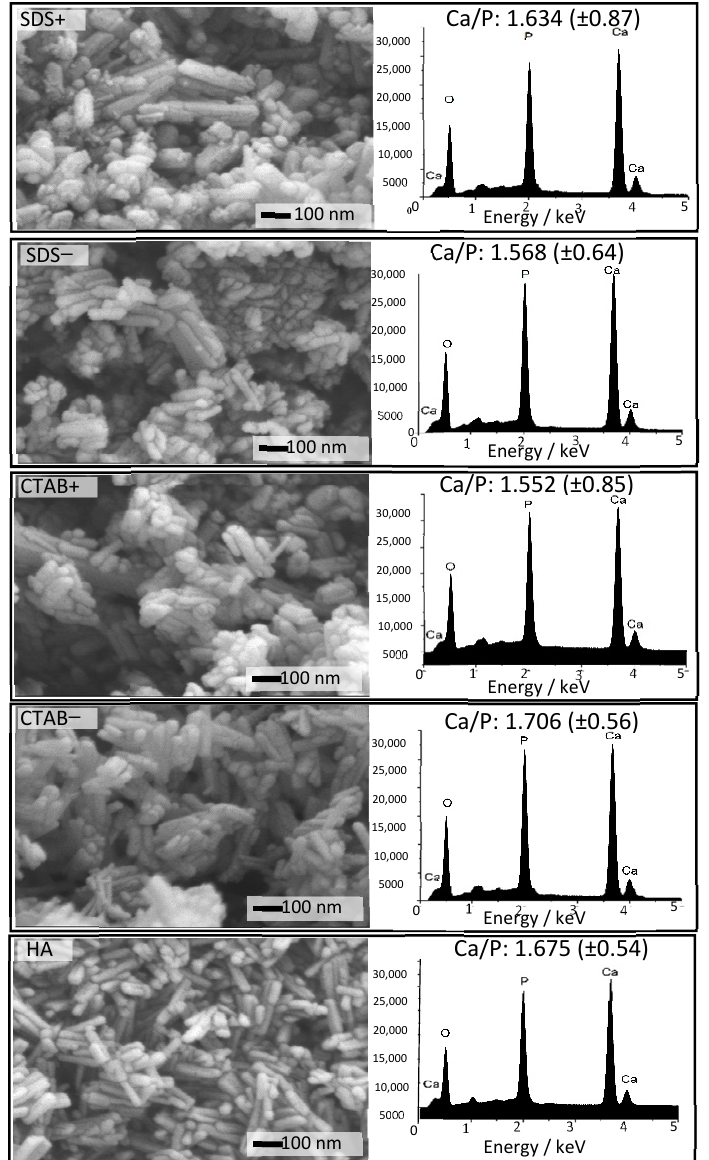
Figure 3. Representative SEM micrographs and EDS spectra of the HA, CTAB − , CTAB+, SDS − , and SDS+ powders.